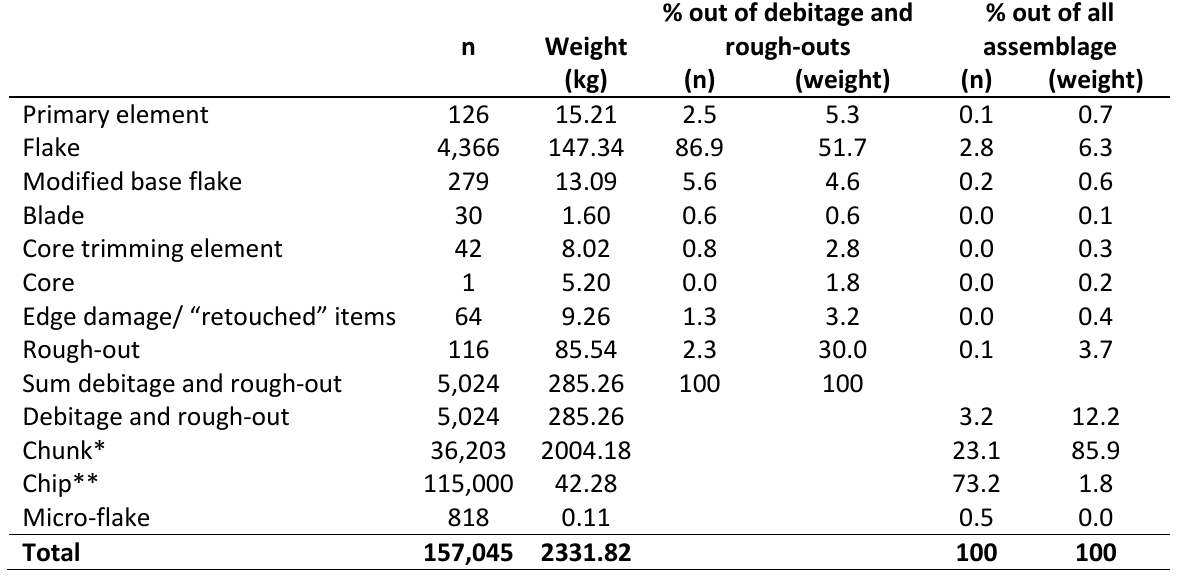
Table 1: The basanite assemblage of Locus 1. *1,154 chunks from the 2007 season were not weighed; their weight was estimated according to the rest of the chunks recorded; **the number of chips is estimated according to series of samples counted and weighed from different squares and spits, including a total of 28,653 chips.